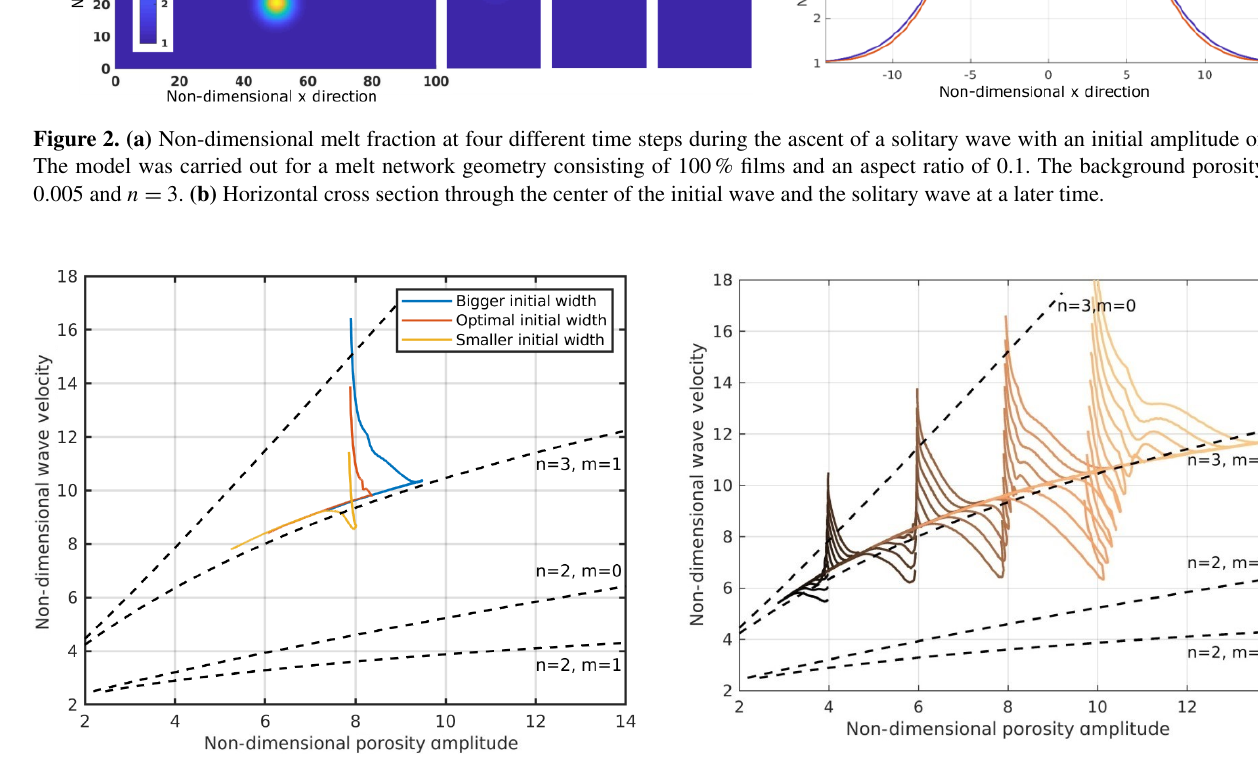
Figure 3. Dispersion curves for three models with an initial width bigger, smaller and approximately equal to the resulting solitary wave. Each model was carried out for a melt network geometry con- sisting of 100% films and an aspect ratio of 0.1. The background porosity is 0.005 and n = 3.